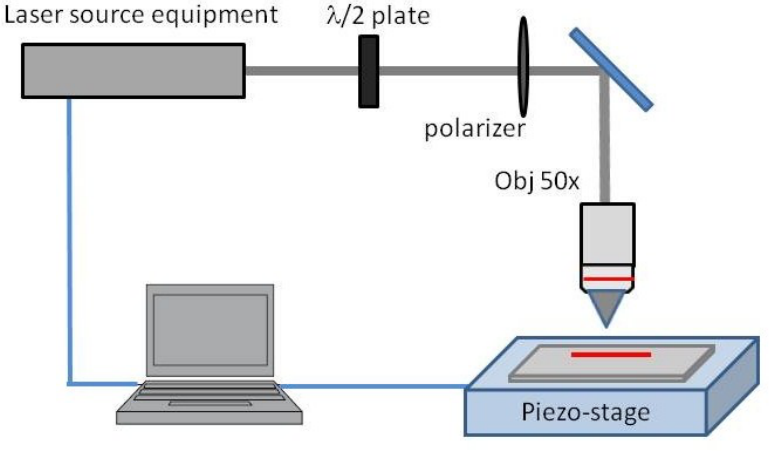
Figure 1. Schemes of the laser ablation set-up used for the material